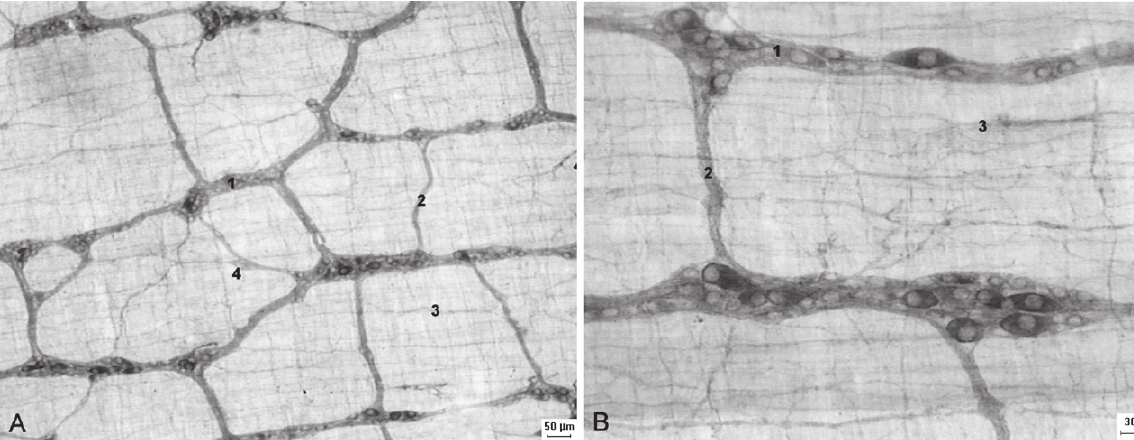
1169 EFFECT OF L-GLUTAMINE ON MYENTERIC NEURON OF DIABETIC RATS